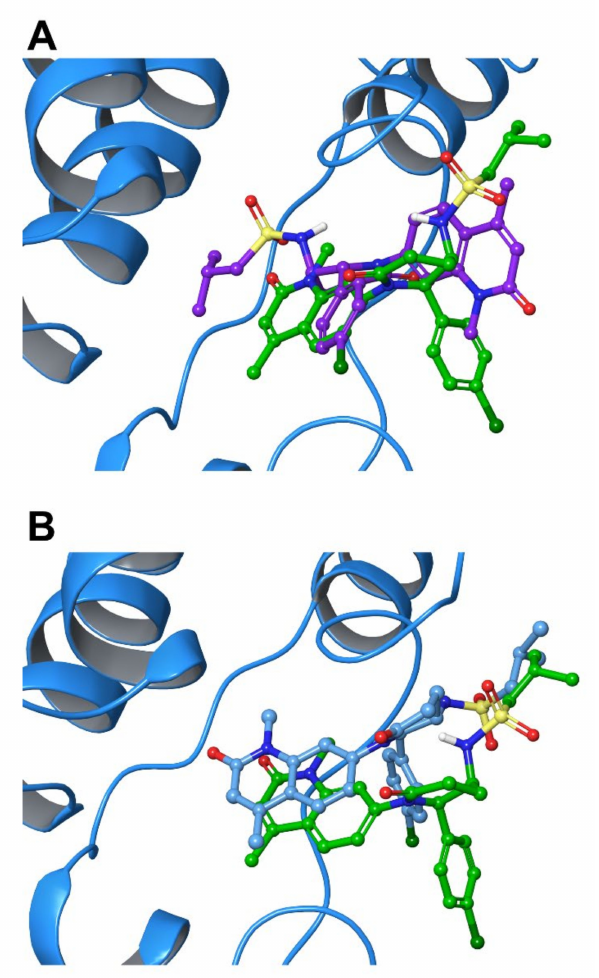
Figure 11. ( A ) Comparison between the two poses of 10 ( 10a , purple carbons, and 10b , green carbons) in BRD9 binding site (cyan ribbons). ( B ) Superimposition between the good pose of 10 (green carbons) and its crystallized binding mode (cyan